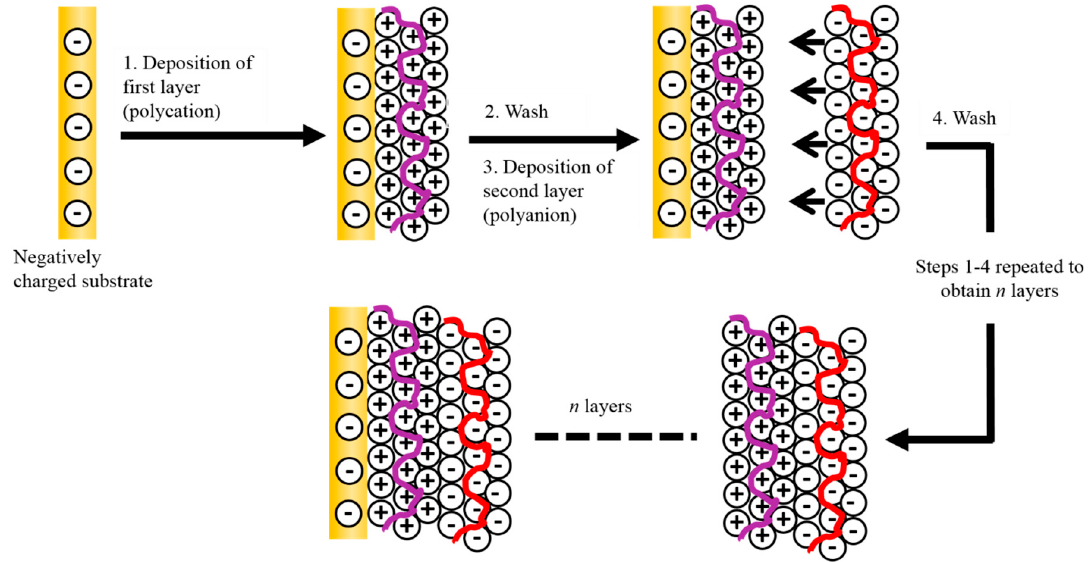
Figure 6. Schematic illustration of LBL assembled multilayer films via electrostatic interaction: A simplified multilayer film assembled from negatively charged substrate with multiple immersion of polyelectrolytes in sequential order to allow the formation of n layers.